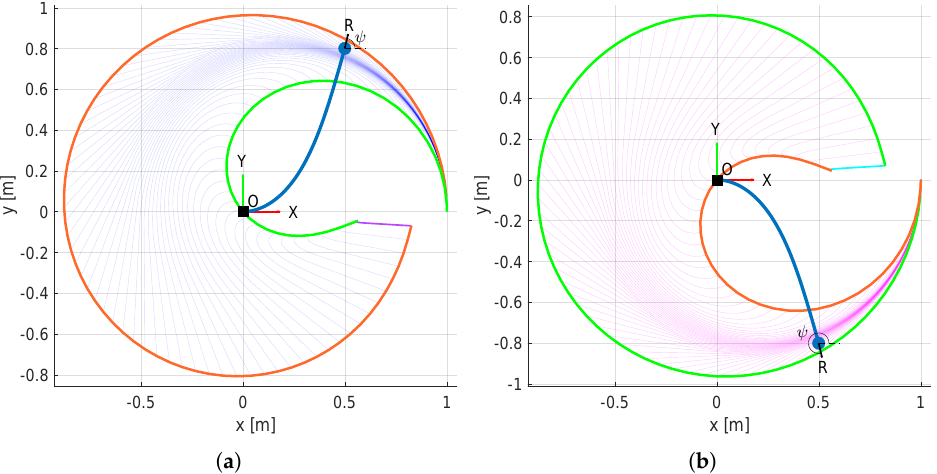
Figure 5. Rod’s end-tip workspace for buckling mode 1. ( a ) Positive k . ( b ) Negative k